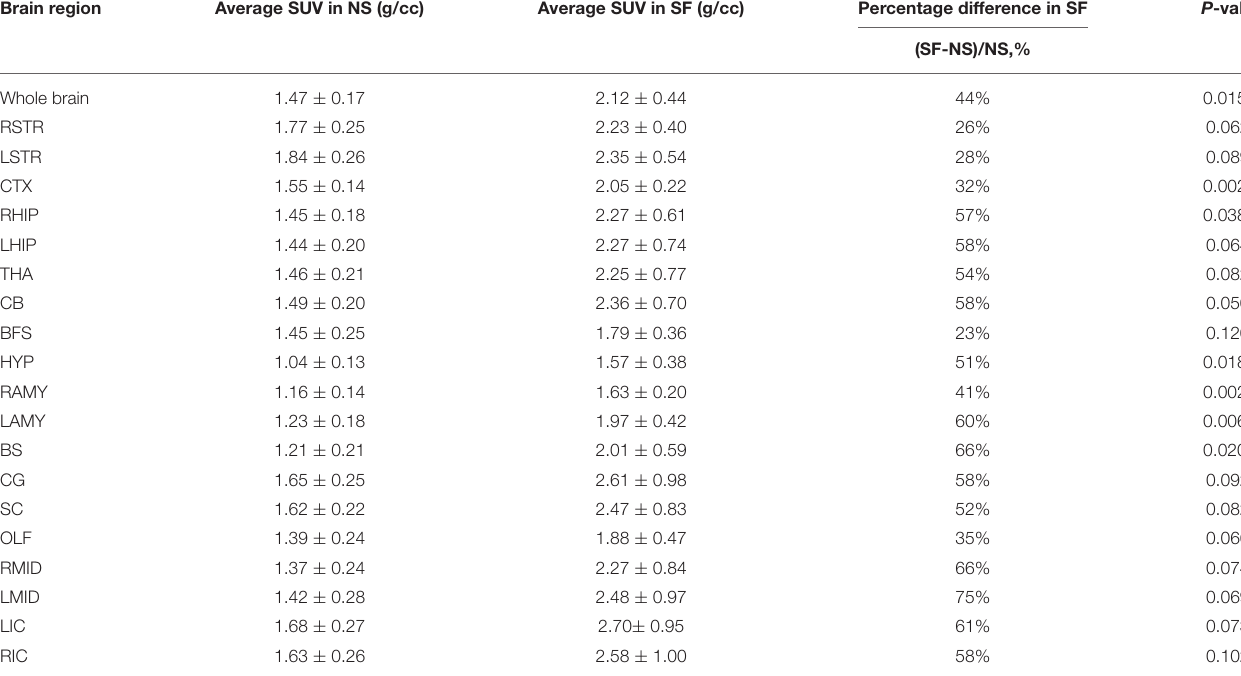
TABLE 1 | 18 F-FDG uptake per brain region in mice. Brain